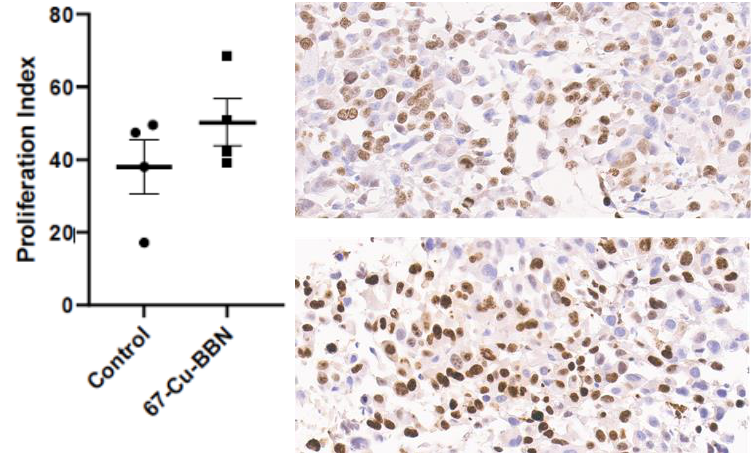
Figure 5. Proliferation index in areas of tumors without necrosis, immune infiltrate or host mouse stroma. The left graph depicts PI values from 4 tumors collected from either saline (control) or 144 MBq [ 67 Cu]Cu-SAR-BBN group. On the right, a fixed field (20 × magnification) was used to identify a region of interest (ROI) containing proliferating tumor cells (not stroma, necrosis, or immune infiltrate). The tumor from mouse 48—control group and tumor from mouse 44—[ 67 Cu]Cu-SAR-BBN group are shown in the top and bottom panels, respectively.